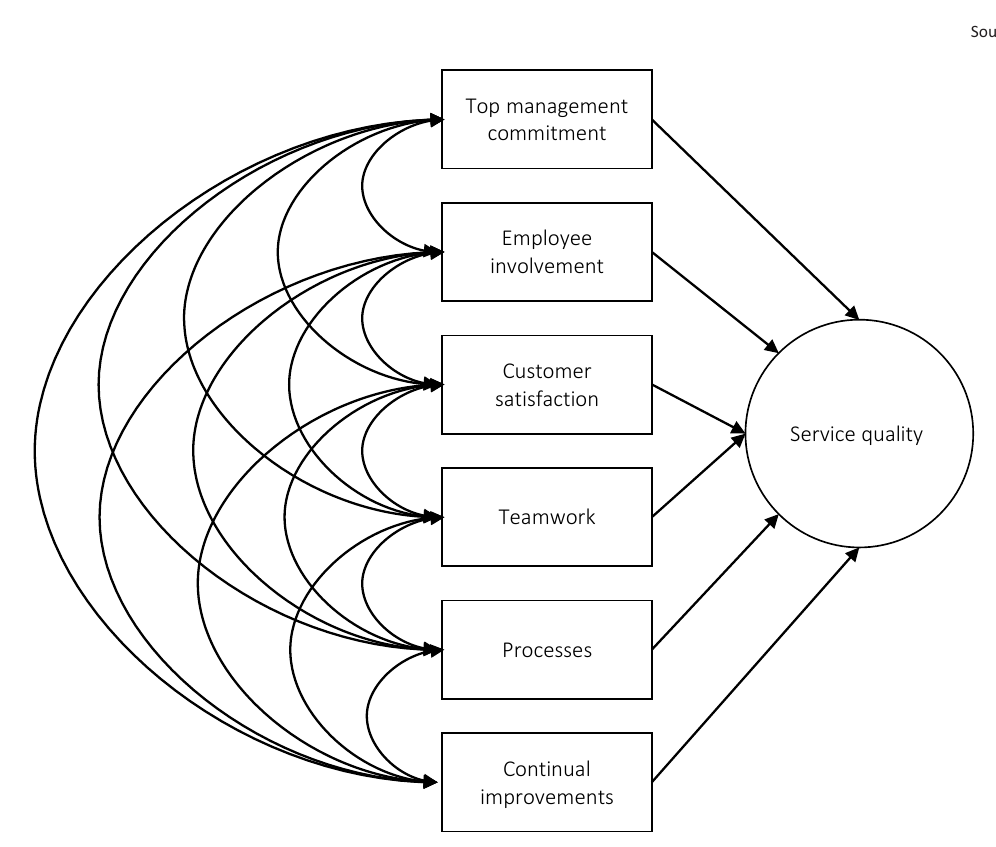
Figure 1. Conceptual